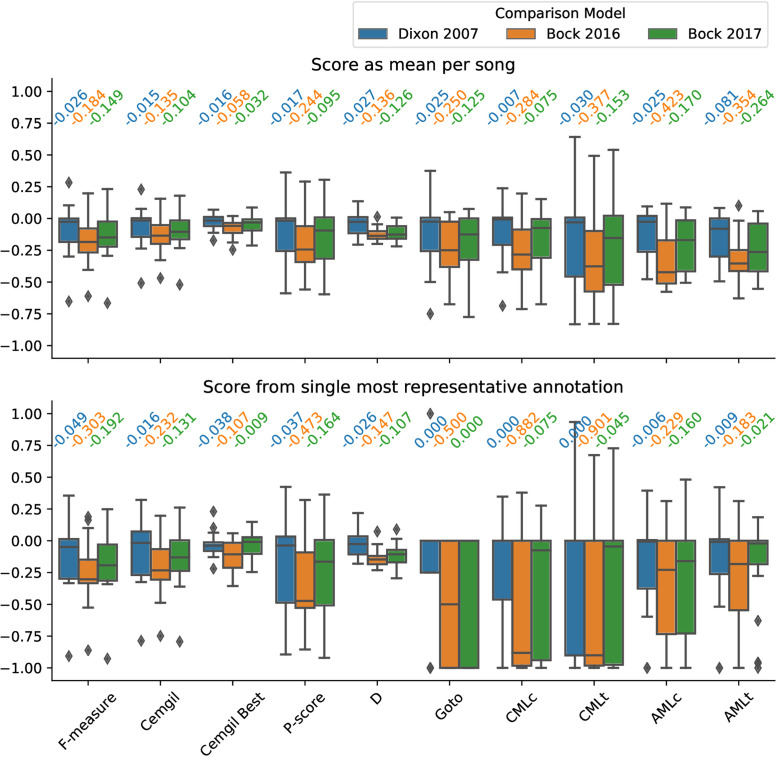
Comparison of THT beat tracking with Dixon 2007 [17], Böck 2016 [23] and Böck 2017 [25].Score difference is presented as a distribution for each metric in the mir_eval package [38]. Each distribution is gathered from 20 points, one for each excerpt in the dataset. Score differences are calculated in two modalities, as the mean across annotators or by selecting a single most representative annotator per excerpt. Above each boxplot the median of each distribution is presented in numbers.